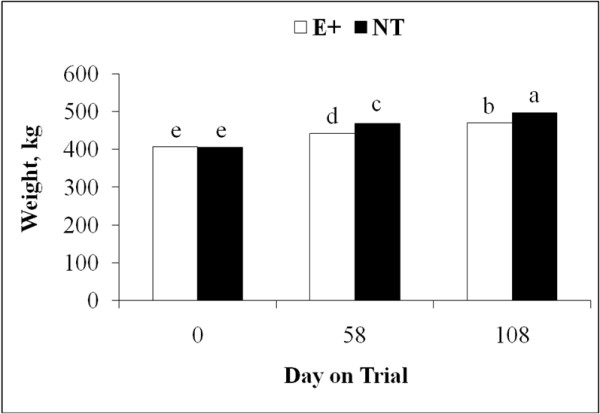
Interaction of forage cultivar and day on body weight of beef heifers; abcdeP < 0.01; pooled SE = 4.9.